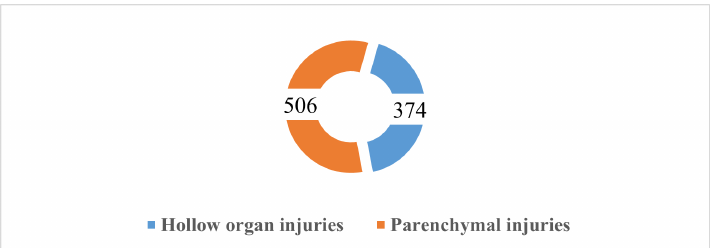
Figure 12. The structure of abdominal injuries in